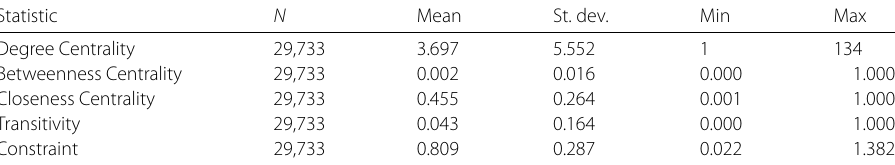
Table 3 Individual-level summary statistics